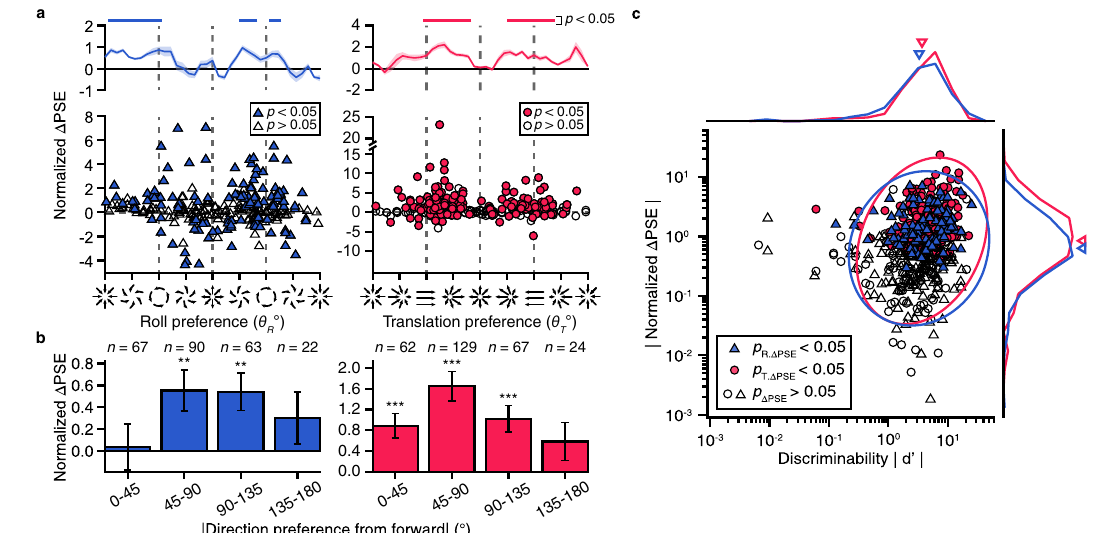
Fig. 5 | Microstimulation induced PSE shift effect depends on neuronal sensi- tivity. Data are similar in fi ne/coarse version in the two animals and have been pooledtogether(SupplementaryFig.5). a Relationshipbetween Δ PSEanddirection preference. Each point represents data from one stimulated site with fi lled symbol represents signi fi cant Δ PSE ( p <0.05, probit regression). Top marginal plots represent Δ PSE as a function of direction preference with a sliding window (step=10°, bin=30°). Shaded area, SEM. Superimposed bars indicate signi fi cant values different from zero ( p <0.05, two-tail t -test). b Average result in a grouped